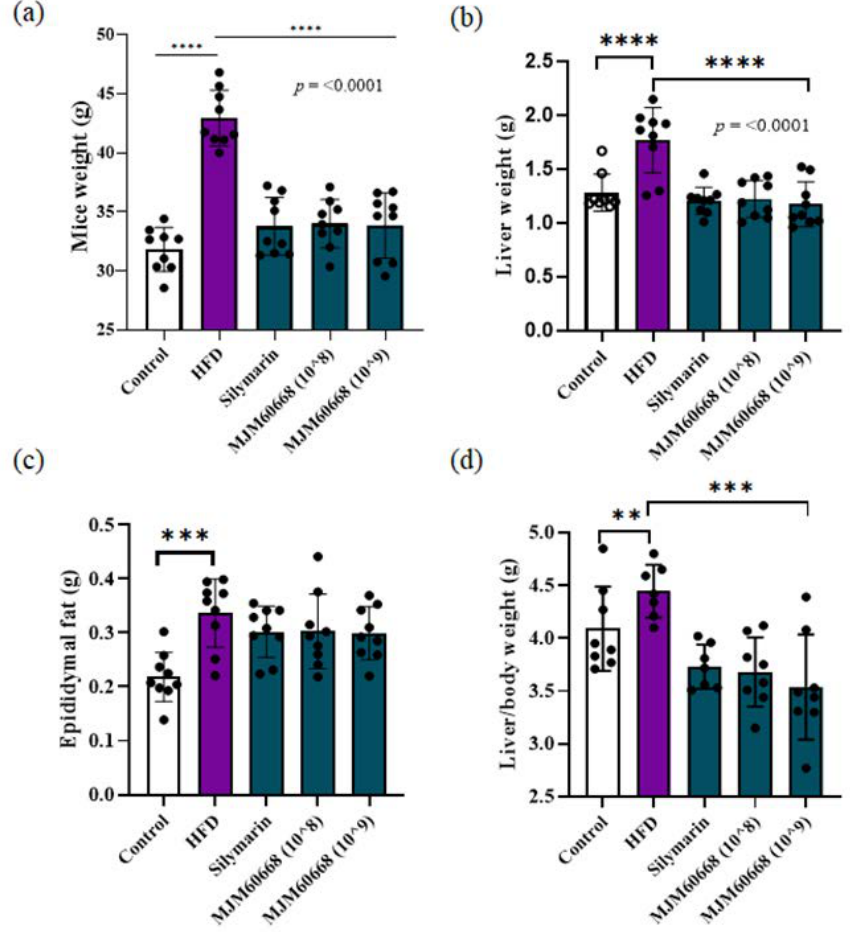
Figure 4. L. reuteri MJM60668 treatment reduces body weight, liver weight, epididymal weight, and liver/body ratio in mice. ( a ) Mice weight after sacrifice ( b ) Liver weight. ( c ) Epididymal fat, ( d ) Liver to body weight ratio represented as the mean ± standard of result. ** p < 0.01, *** p < 0.001, **** p < 0.0001 compared with HFD